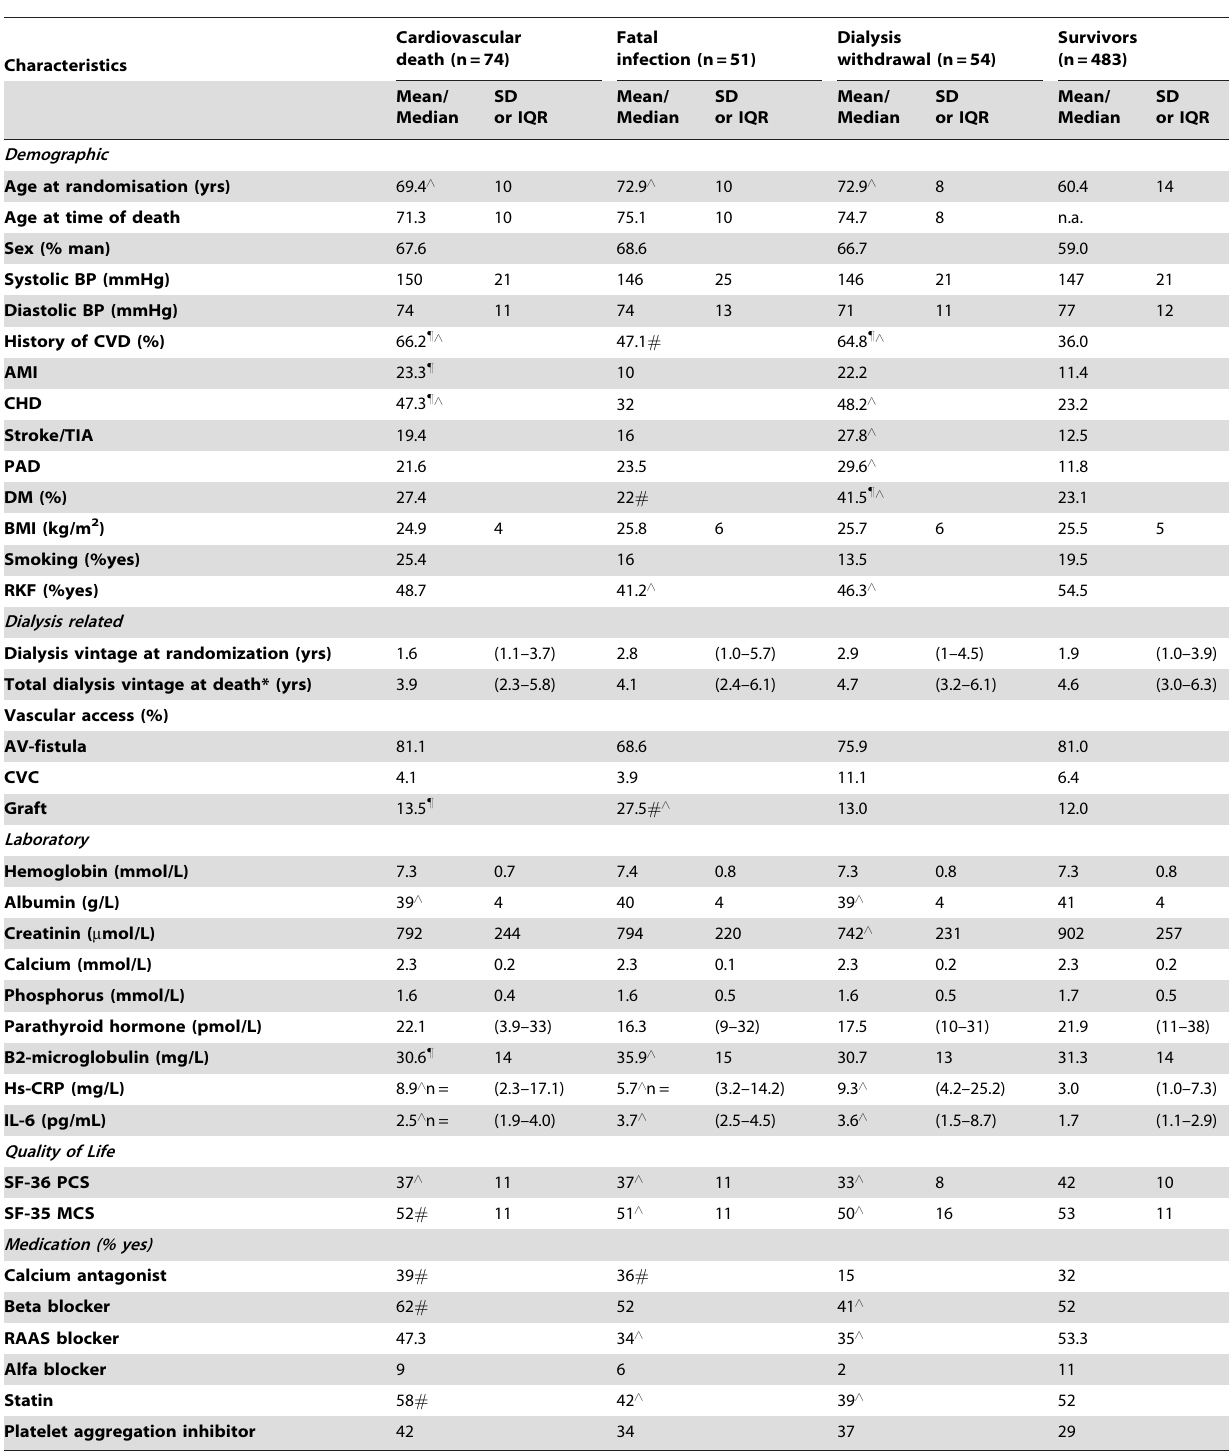
Table 4. Baseline characteristics of patients who died during follow-up, from cardiovascular death, infection or dialysis withdrawal and of patients who survived (on treatment